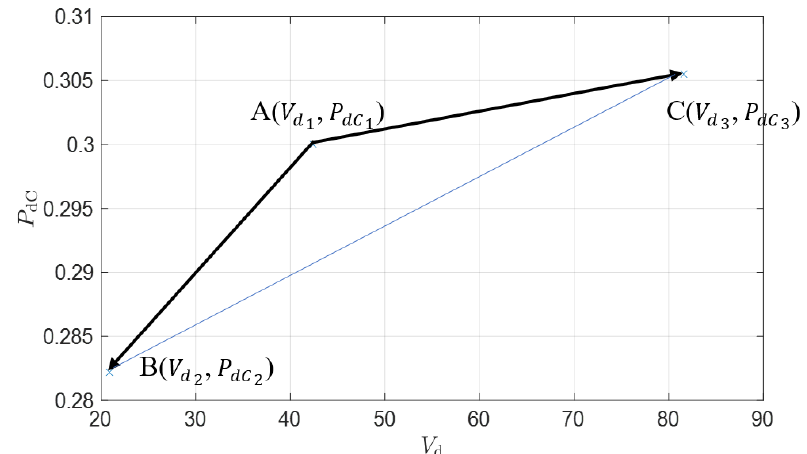
Figure 1. Plot of P dC versus V d for N-KZFS11, N-SF66, and N-PK52A glasses. In Figure 1, the AB vector coordinate is (V d2 − V d1 , P dC2 − P dC1 ) and the AC vector the AB and AC vectors is shown in Equation (23).